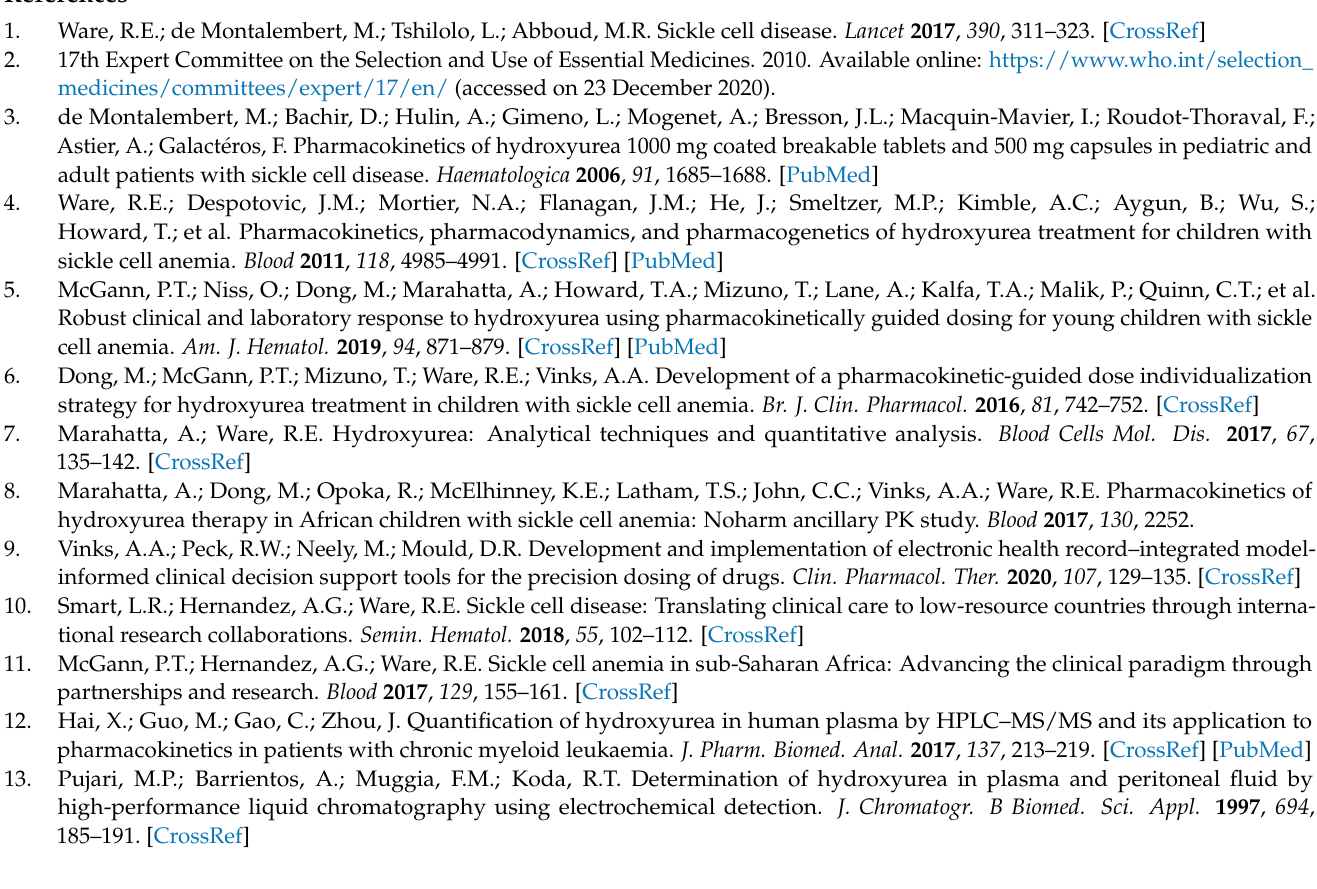
high (150–500 µ M) hydroxyurea concentrations; Figure S10: Comparisons of the limit of detection for hydroxyurea taken from linear regression analysis of the calibration curve at each potential for the gold electrode (grey) and the MoS2 electrode (black) and for different concentration ranges; Figure S11: The PCA analysis is used to ensure that the datasets resulting from the data pretreatment step are correlated with their original counterparts; Table S1: The composition of our simulated serum consists of a list of 28 interfering molecules with a precise concentration (taken as the upper biological concentration limit); Table S2. The values of the fitted parameters of the EIS analysis; Table S3: Linear regression analysis of the calibration curve of hydroxyurea at the gold and the MoS2 modified electrodes; Table S4: Linear regression analysis of the calibration curve for uric acid and ascorbic acid at the gold electrode and the MoS2 modified electrode; Table S5: Table depicting the important physicochemical parameters of the organic molecules used in the study; Table S6: Comparisons with literature; Table S7: Limit of